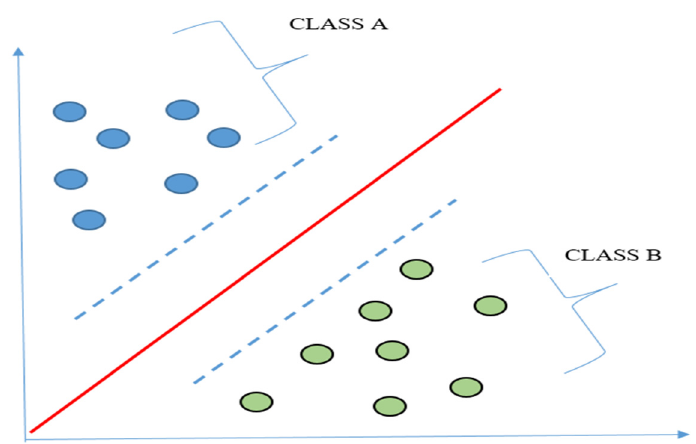
Figure 8. Support vector machine (SVM).